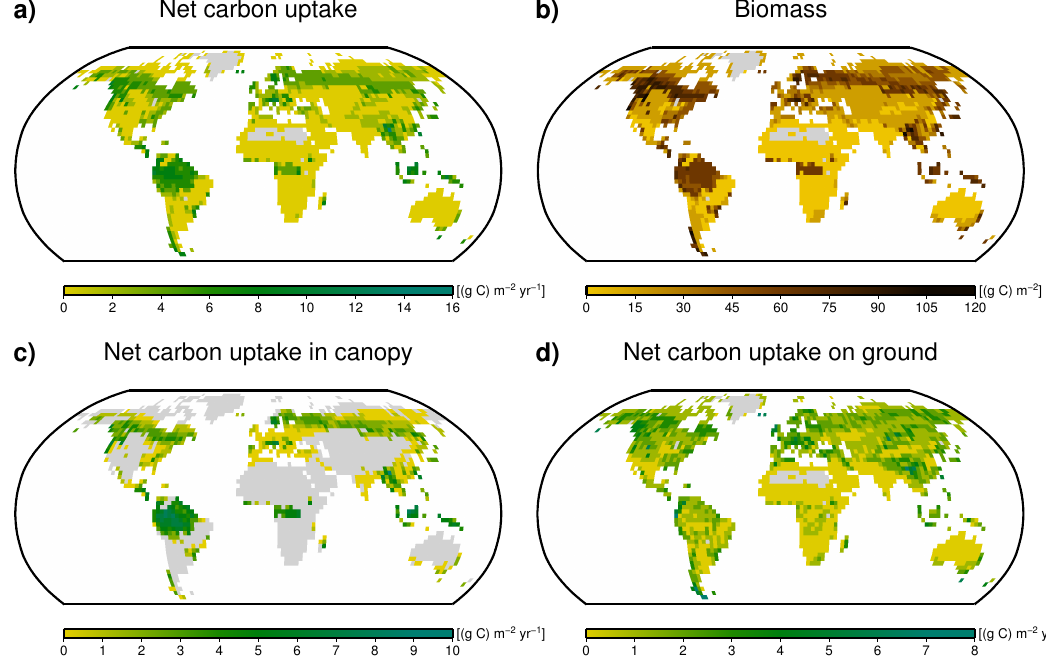
Figure 5: Global maps of model estimates. a) Net carbon uptake by lichens and bryophytes. b) Biomass of lichens and bryophytes. c) Net carbon uptake by lichens and bryophytes living in the canopy. d) Net carbon uptake by lichens and bryophytes living on the ground. The estimates are based on time averages of the last 100 yr of a 2000-yr run with 3000 initial strategies. They correspond to the “average” weighting method (see Sect. 2.3). Areas where no strategy has been able to survive are shaded in grey. the parameters. This is done to avoid generating unrealistic climatic